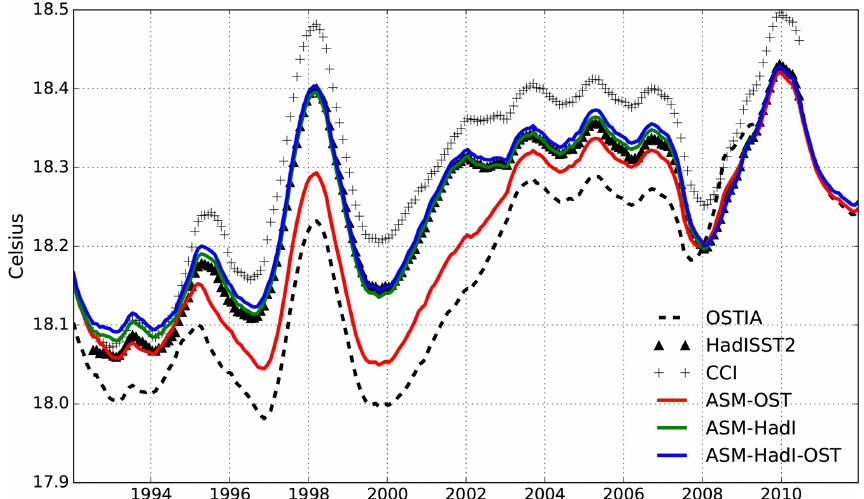
Figure 4. Time series of global mean SST ( ◦ C) from ocean reanalyses when assimilating different SST and SIC analysis products. A 12- month running mean filter has been applied.